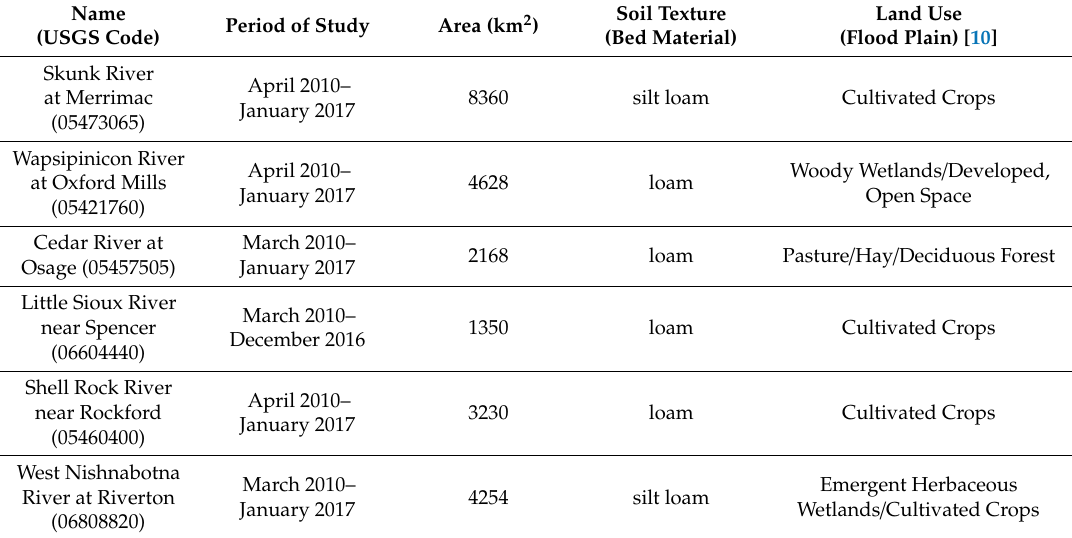
Table 1. List of USGS sites considered, available time period of rating curve and shift records, basin upstream area, soil texture and land